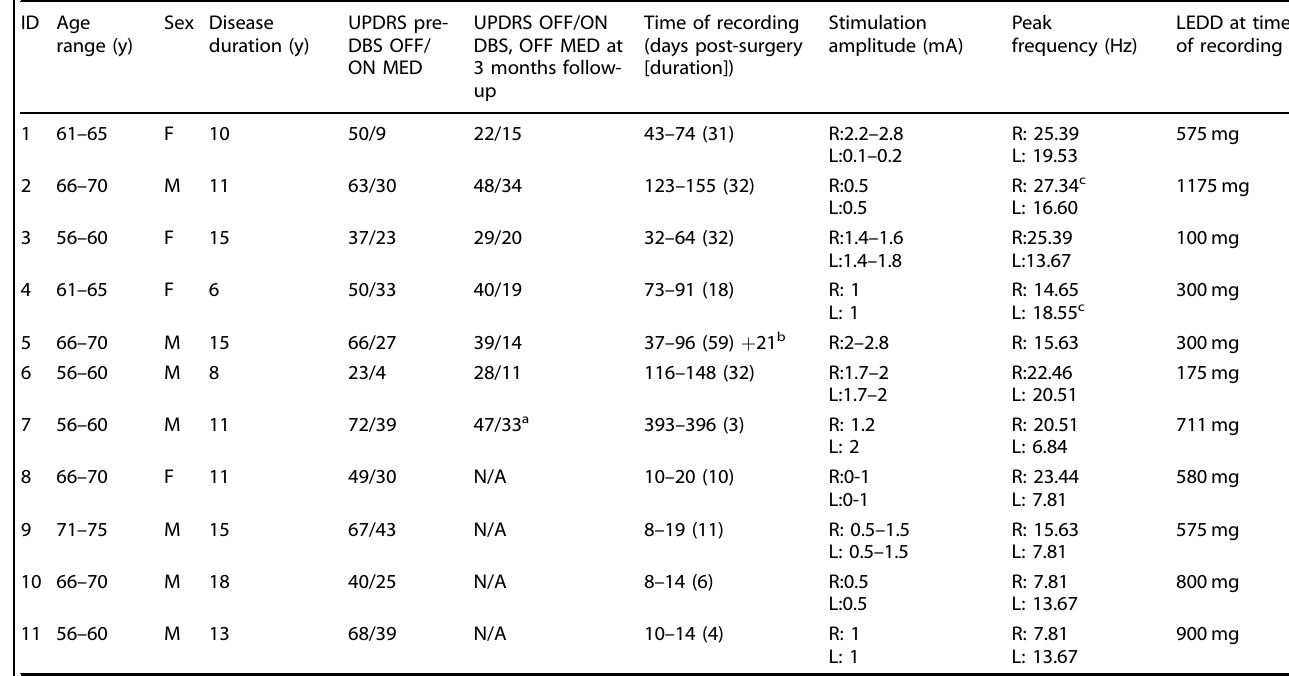
Table 2. Clinical information and recording